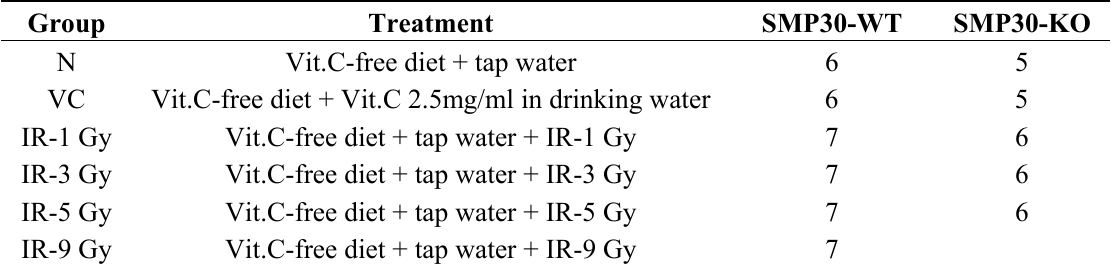
Table 1. Group and treatment protocol of SMP30-WT and SMP30-KO mice. Group Treatment